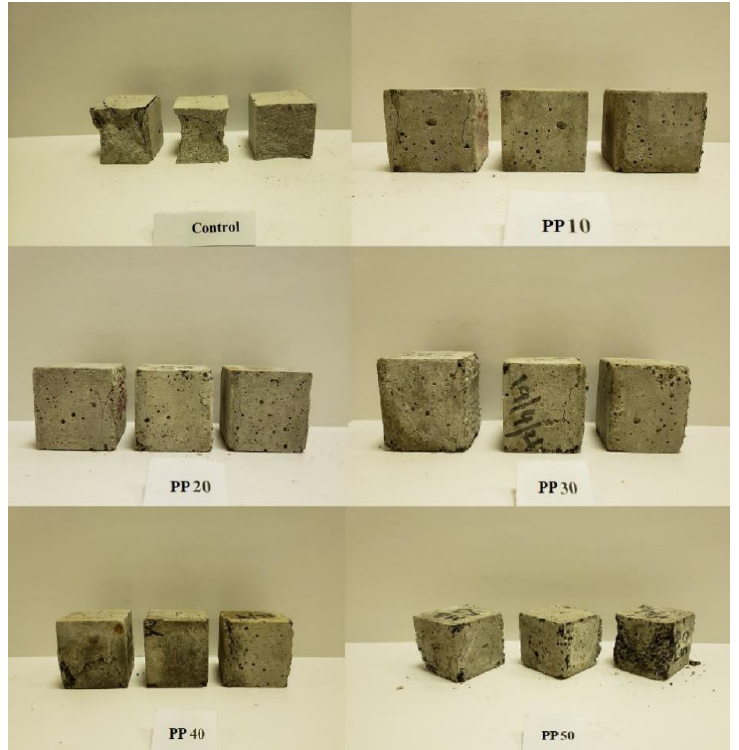
Figure 6. Failure modes of the proposed mortars containing various contents of rPP as natural aggregate replacement.